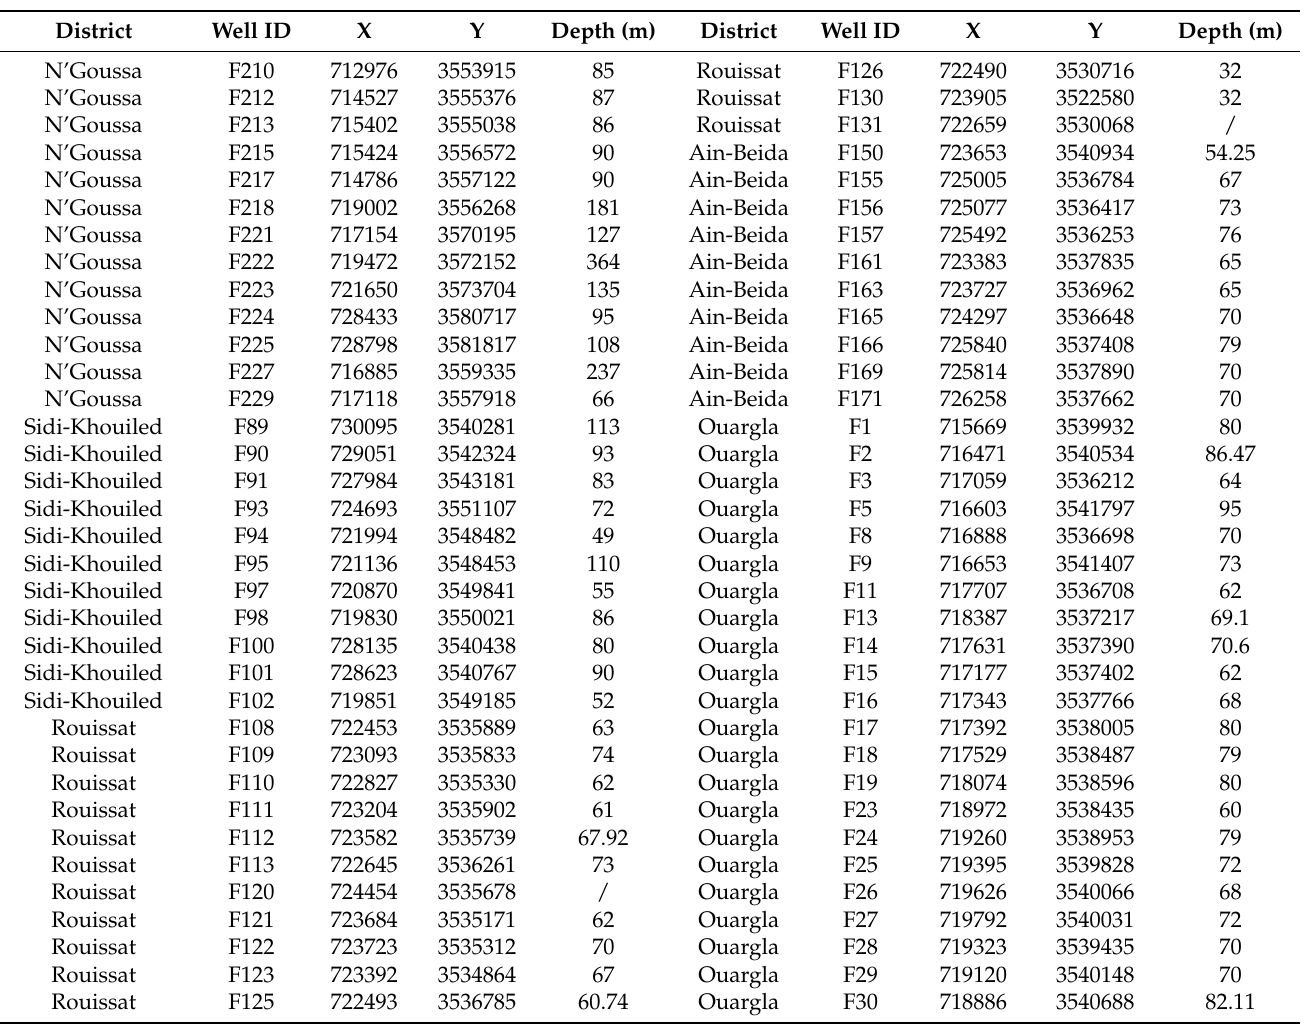
Table A1. Well longitude and latitude